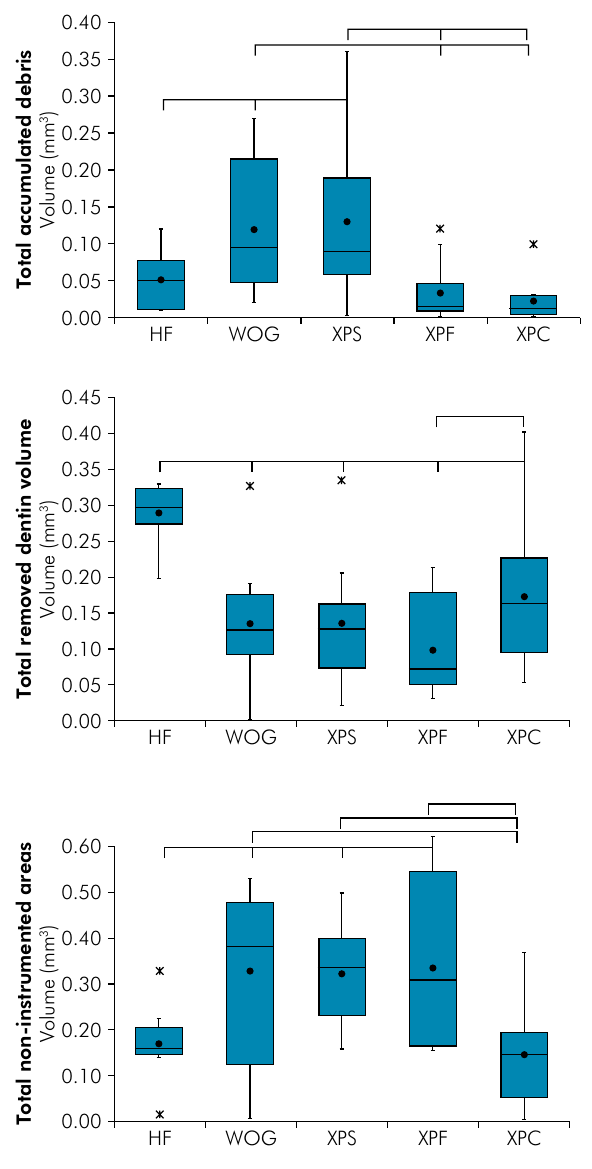
Figure 3. Quantitative results of the mechanical outcomes of instrumentation (accumulated hard tissue debris, removed root material volume, and non-instrumented areas) for all root canal lengths, according to the different instrumentation